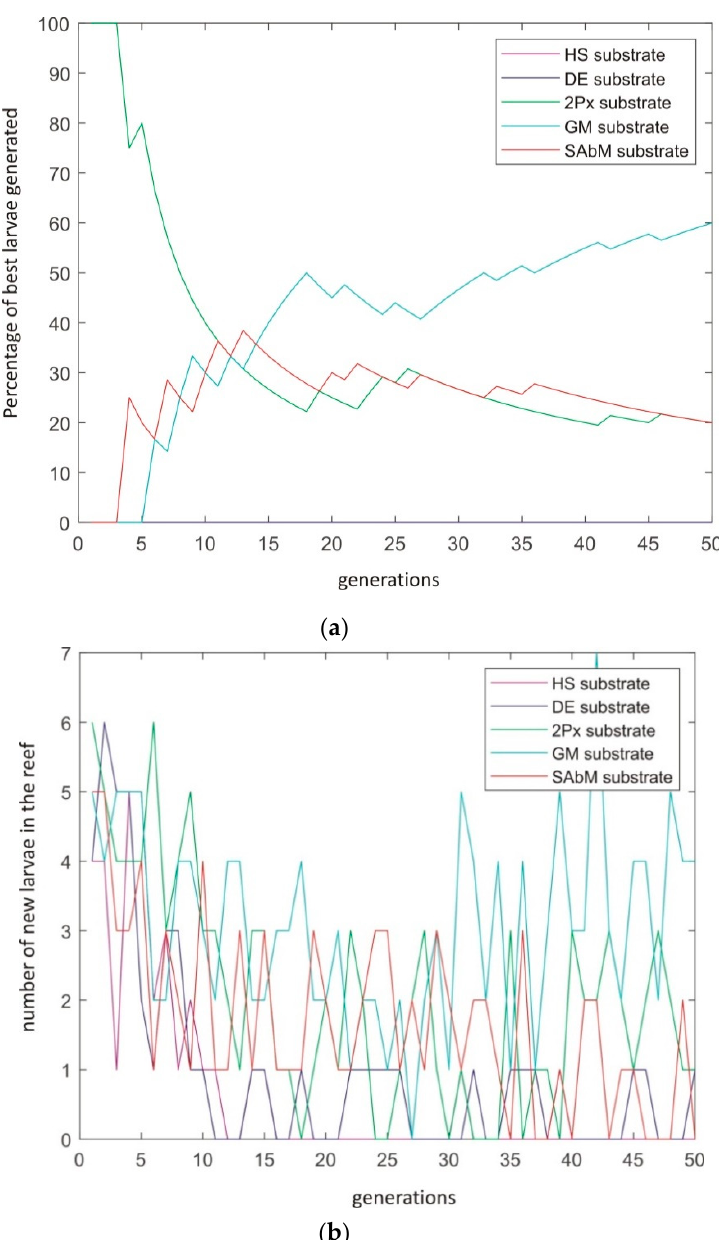
Figure 6. CRO-SL substrate performance metrics for the two-frequencies antenna optimization. ( a ) Best substrate for larvae generation; ( b ) best substrate for getting larvae into the reef.